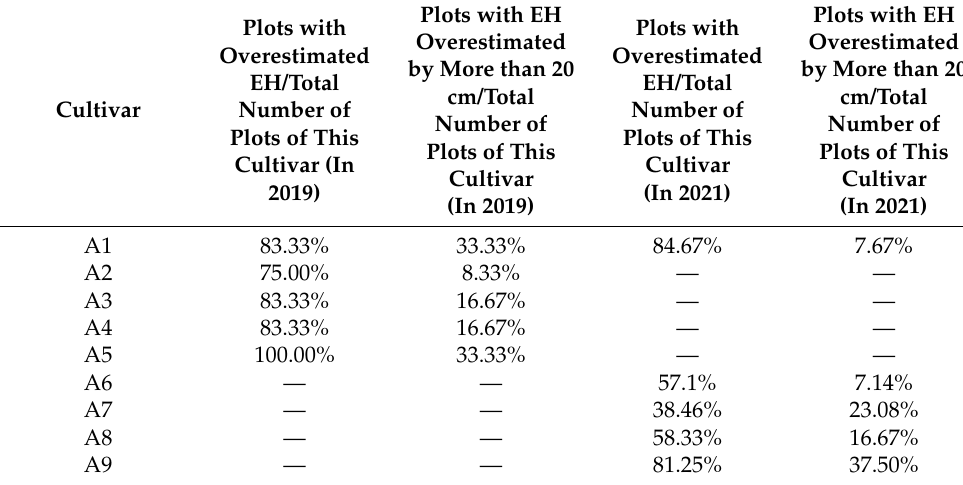
Table 9. EH overestimation using TLS data for different cultivars.